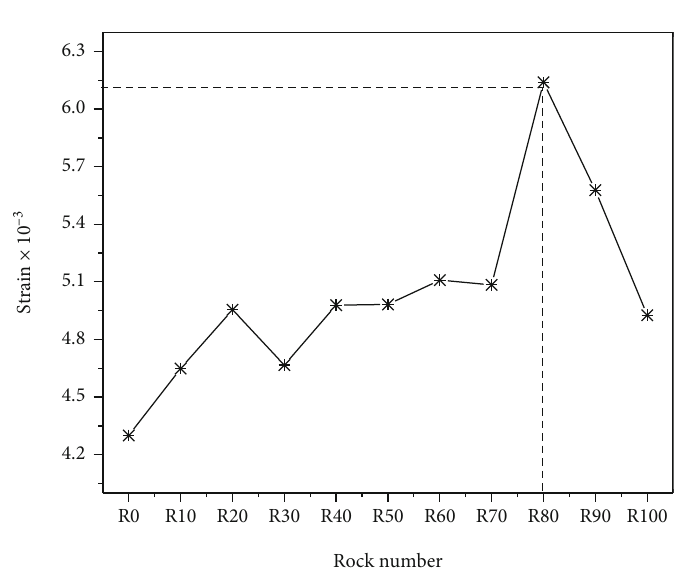
Figure 15: Maximum strain-CRV